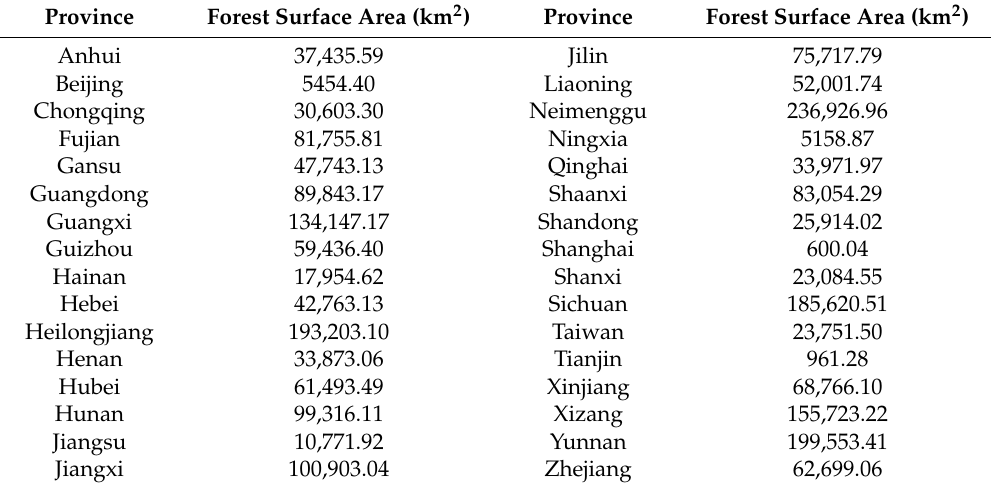
Table 5. Forestland surface area of each